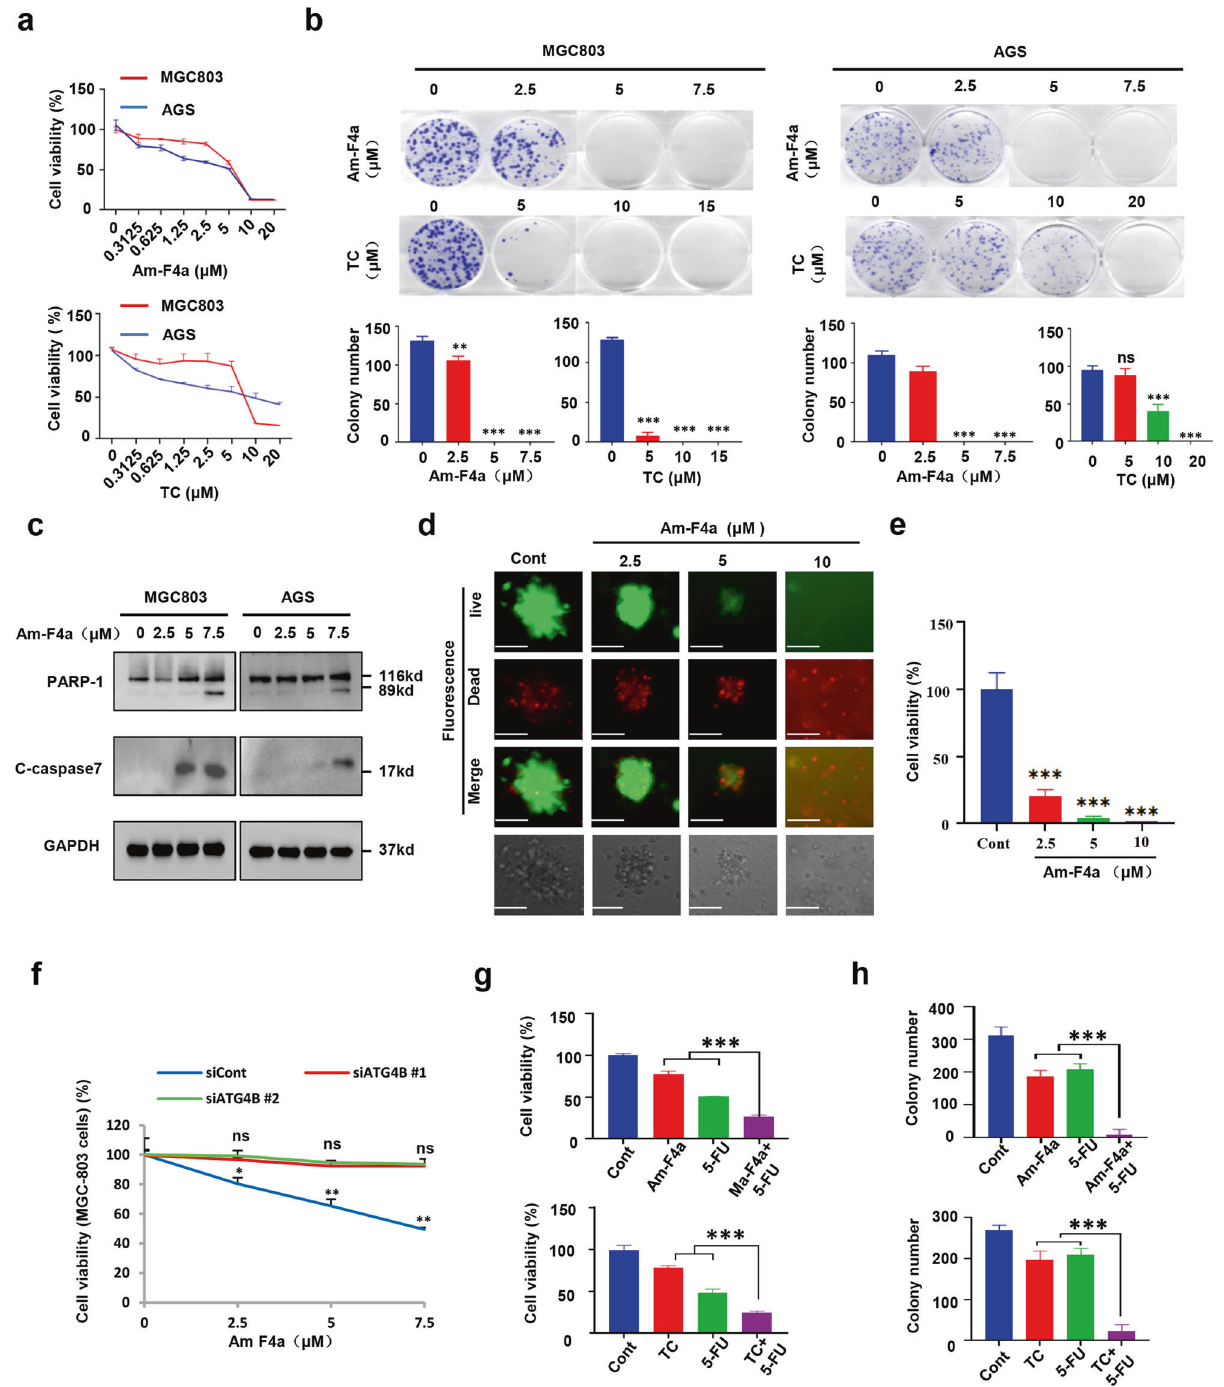
Fig. 4 Am-F4a inhibits GCa cell growth via inhibition of ATG4B and improves anti-GCa ef fi cacy of 5-FU. a Cell viability was evaluated by CCK-8 assay of MGC803 and AGS cells treated with Am-F4a and Tioconazole (TC). b Colony formation of MGC803 and AGS cells treated with Am-F4a at indicated concentration. Representative images were shown, and colonies were counted. c Immunoblotting analysis of cleaved PARP-1 and caspase 7 in MGC803 and AGS cells treated with Am-F4a at indicated concentration. Representative blots were shown. d , e PDX- derived organoids were treated with DMSO or indicated concentrations of Am-F4a for 4 days. Representative images were taken under a fl uorescence microscope or a standard light microscope (scale bar, 50 μ m) ( d ). Cell viability in organoids was measured with Cell Titer-Glo ( e ). f MGC803 cells were transfected with ATG4B or control siRNA for 48 h and then treated with Am-F4a for another 24 h. Viable cells were collected and counted. g MGC803 cells were treated with Am-F4a (4 μ M) or TC (5 μ M) alone, or in combination with 5-FU (2 μ M) for 48 h. Viable cells were collected and counted. h MGC803 cells were treated with Am-F4a (4 μ M) or TC (5 μ M) alone, or in combination with 5-FU (2 μ M) for 48 h. Colonies were stained and counted. All data shown above are mean ± SD, n = 3, Student ’ s t test, * p < 0.05, ** p < 0.01, *** p <